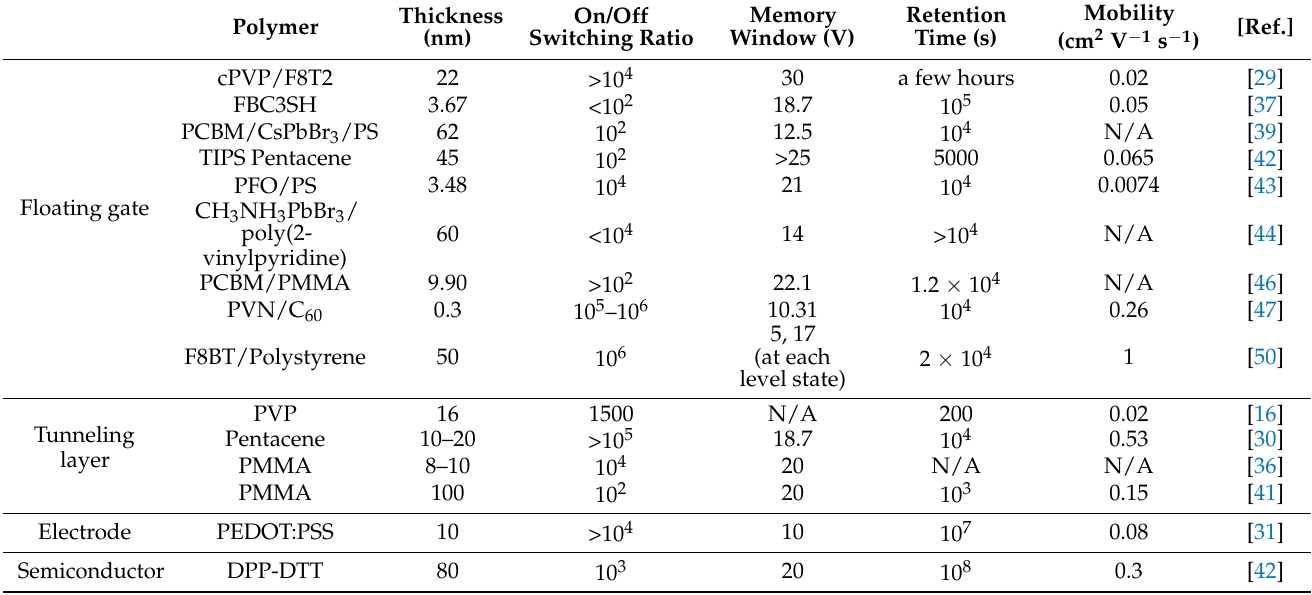
Table 1. Polymer-based floating-gate memory performance